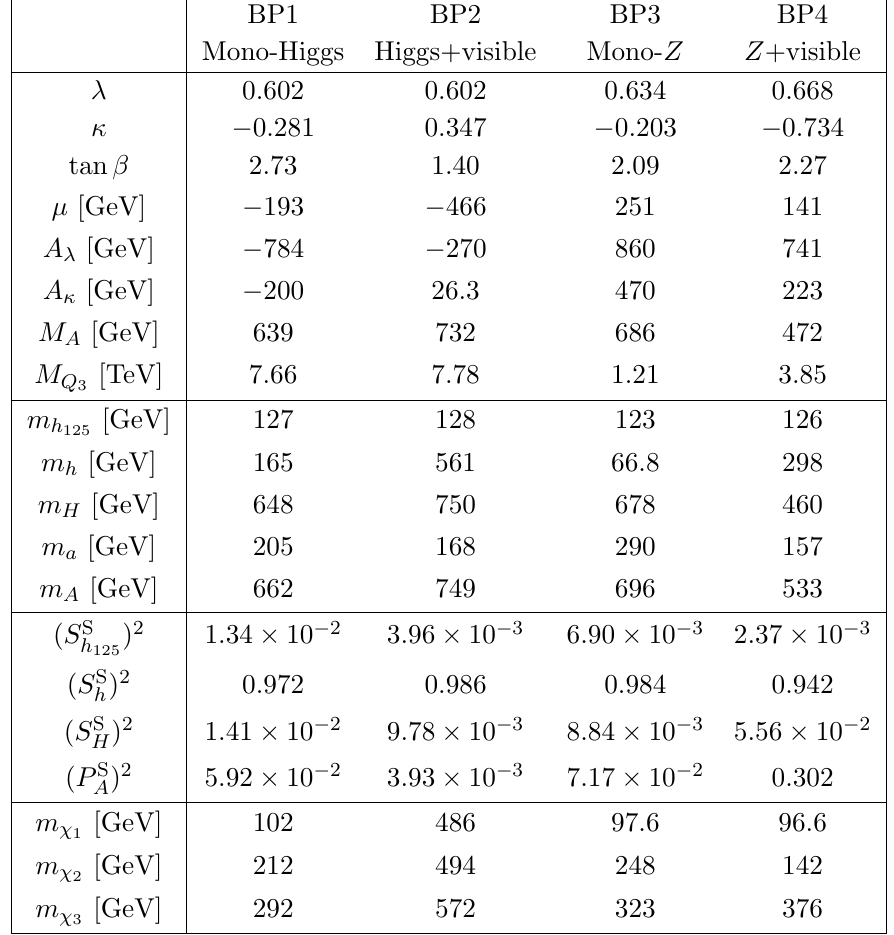
Table 3 . NMSSM parameters and mass spectra for our benchmark points categorized according h i to max (cid:22) 3000fb (cid:0) 1 (Higgs cascades) , BP1: Mono-Higgs, BP2: Higgs+visible, BP3: Mono- Z , and Proj : BP: Z +visibles. The (cid:12)rst block from the top shows the parameters used as input parameters in g where the (cid:12)rst 6 parameters are those appearing in the NMSSMTools f (cid:21); (cid:20); tan (cid:12); (cid:22); A (cid:21) ; A (cid:20) ; M Q 3 scalar potential, cf. eq. (2.3), and M Q = M U is the stop mass parameter which controls the 3 3 the value of M A , de(cid:12)ned in eq. (2.18). As noted in section 2.3, the remaining parameters are